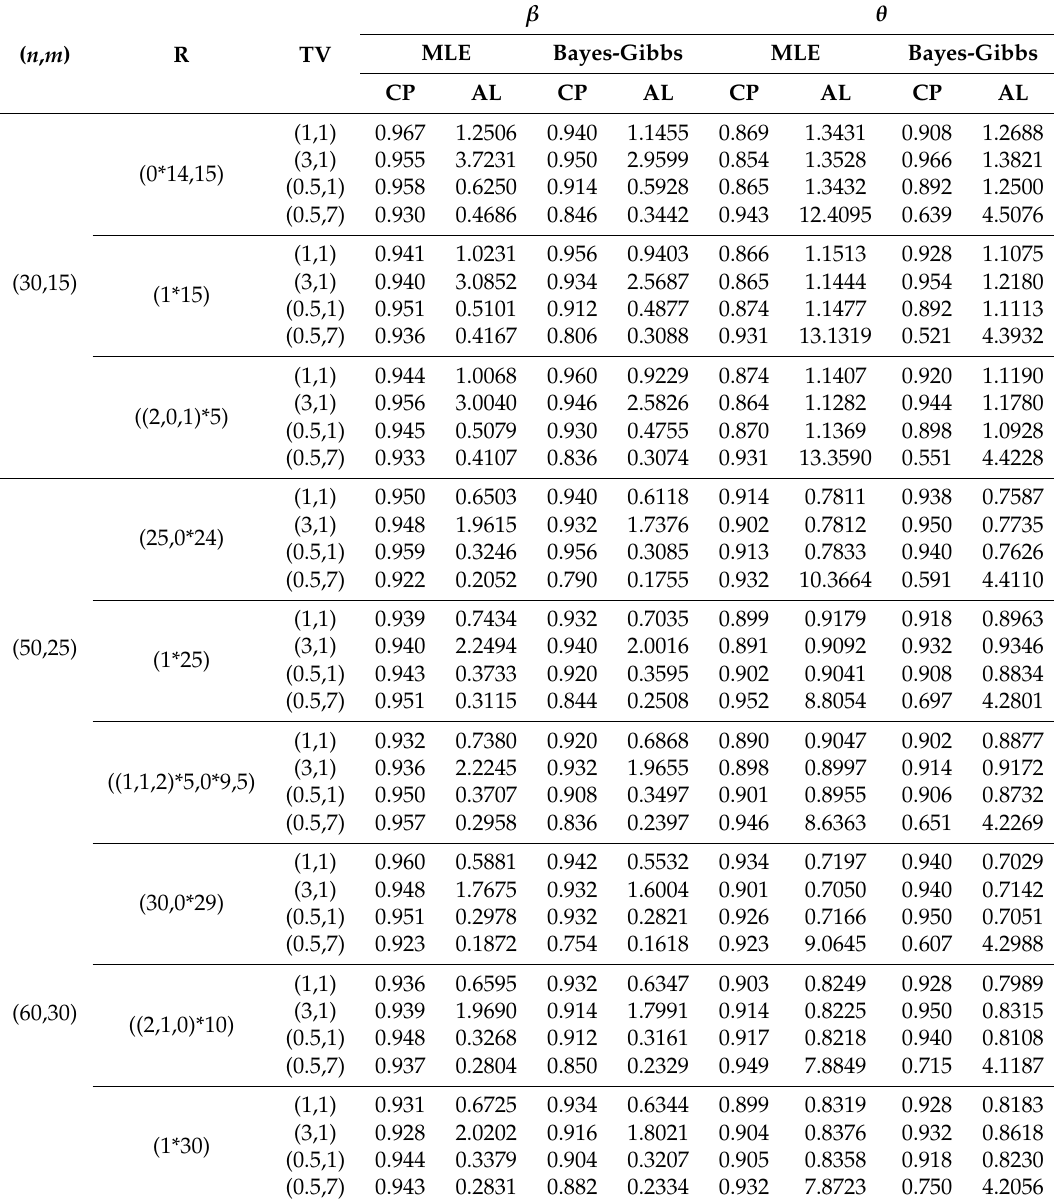
Table 4. Coverage probability (CP) and average length (AL) of 95% intervals when T =